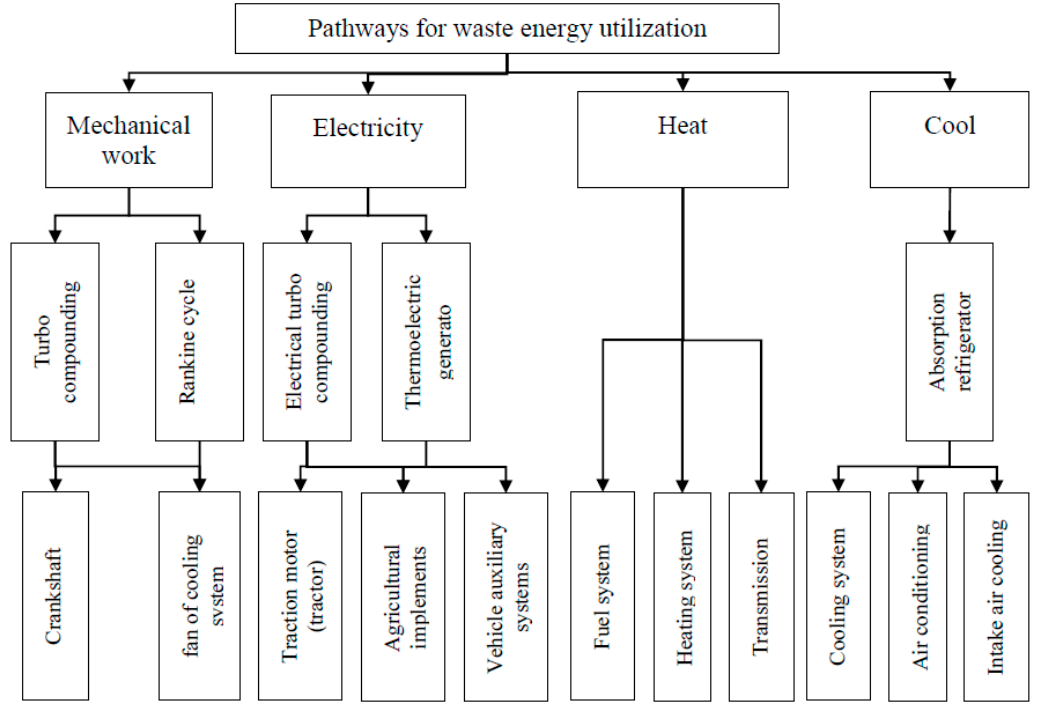
Figure 15. Pathways for waste energy conversion. Source: developed by authors .